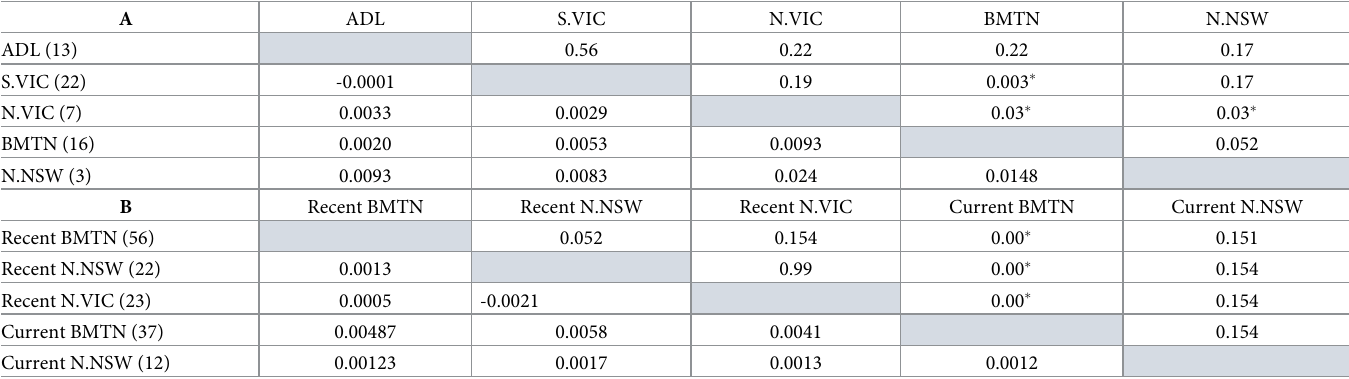
Table 1. Pairwise population genetic differentiation between historic (A) and contemporary (B) a-priori regent honeyeater populations (see Fig 1 for location infor- mation). F ST values are below diagonal and FDR corrected P values are above diagonal. Sample sizes for each population are shown in parentheses. � Significant ( P < 0.05) population genetic